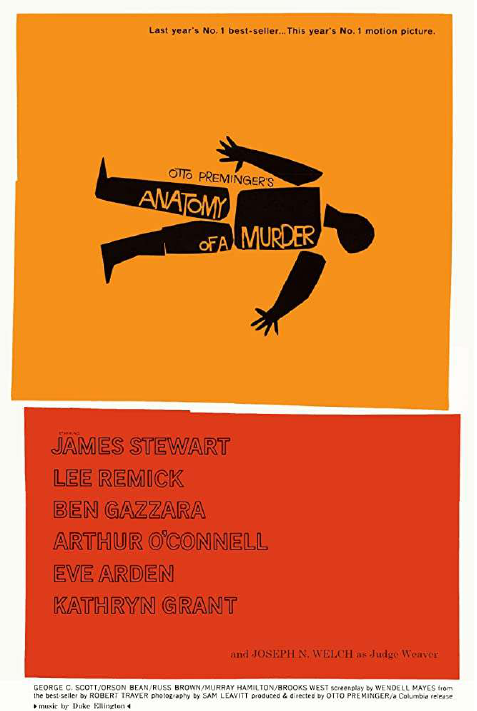
Figure 1: Poster for Anatomy of a